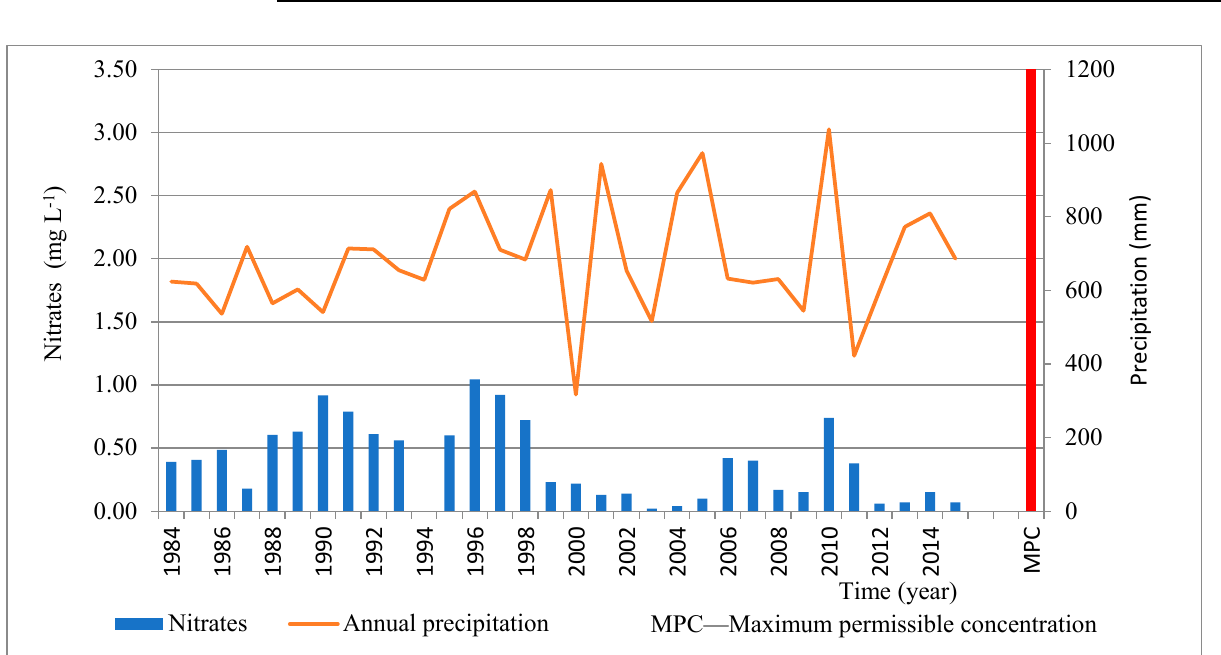
Table 3. Concentrations of Fe, Mn, NH 4 , and NO 3 in the period 1984–2015.